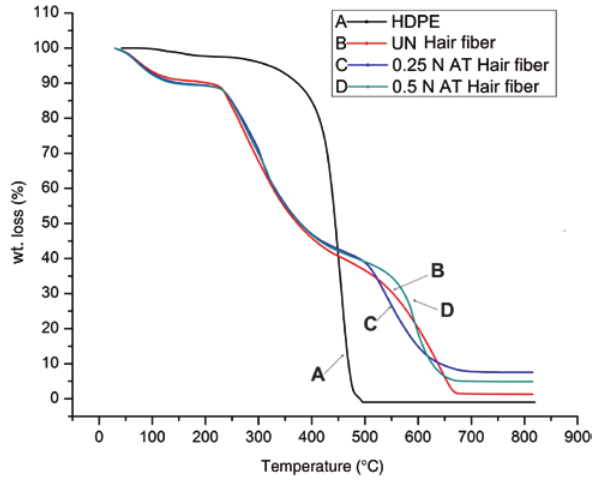
Figure 3: TGA thermograms of HDPE, untreated and treated HF.